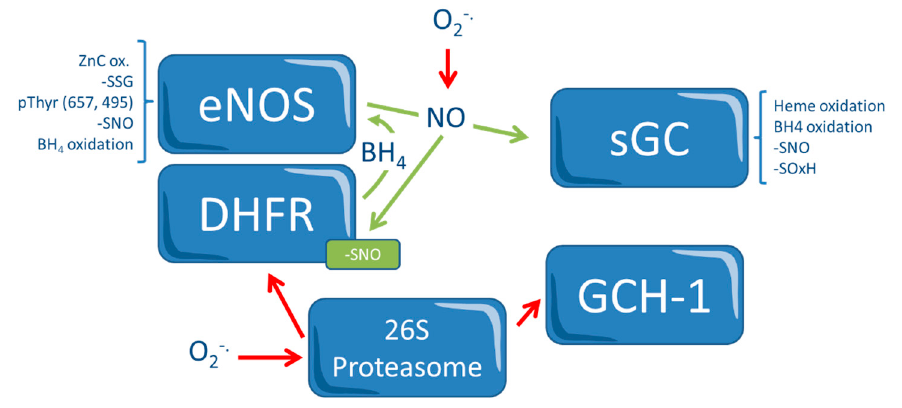
Figure 1. Redox-control in the NO Pathway. Redox-dependent pathways that regulate nitric oxide (NO) and vascular homeostasis. The endothelial nitric oxide synthase (eNOS) and the soluble guanylyl cyclase (sGC) present a number of redox switches, which act directly or indirectly (for instance, in the case of the 26S proteasome, which is activated via 3-nitrotyrosine (3NT) modification causing inactivation of the eNOS cofactor tetrahydrobiopterin (BH 4 ) synthase GTP-cyclohydrolase (GCH-1), and of BH4 recycling enzyme dihydrofolate reductase (DHFR). Oxidation of BH 4 causes a positive feedback mechanism leading to further oxidative stress. Red arrows indicate inhibition. In contrast, NO prevents proteasomal DHFR degradation via tyrosine nitration of the 26S proteasome. O2 − : superoxide anion; -SNO: s-nitroso-thiols; -SOxH: oxidized thiol; -SSG: glutathione disulfide; ZnC: Zinc; pThyr: phosphorylated thyrosine.